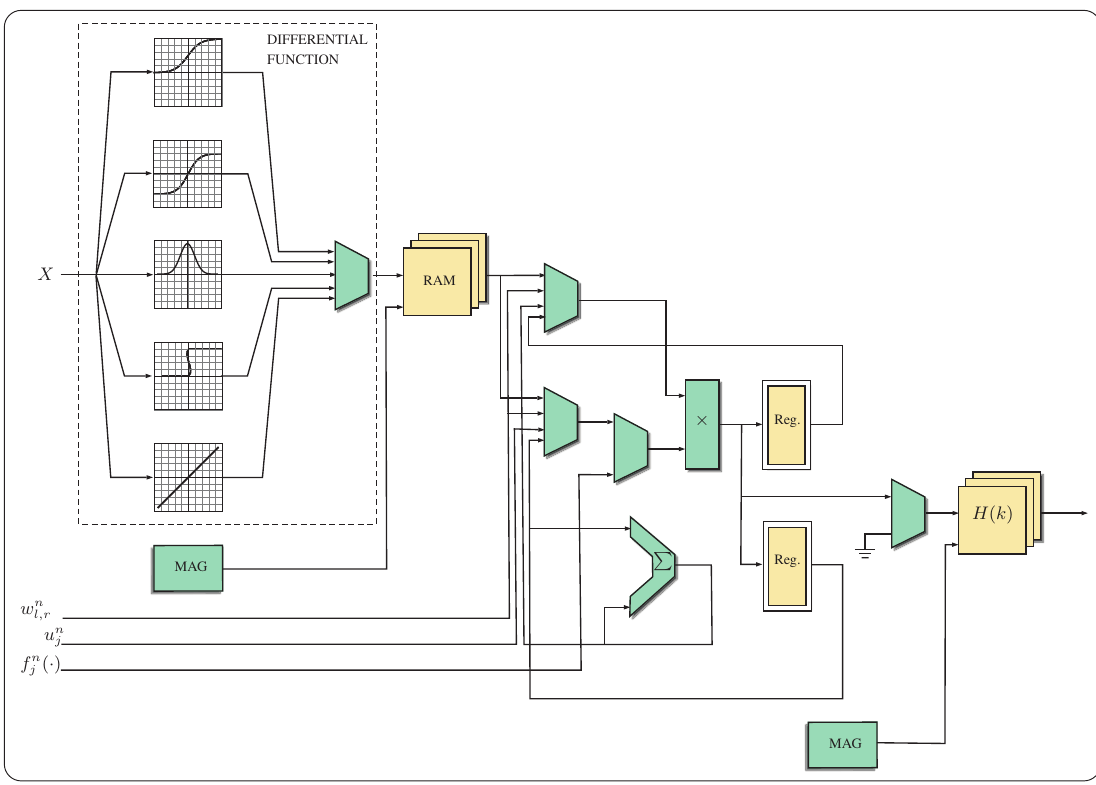
Figure 7. Jacobian matrix